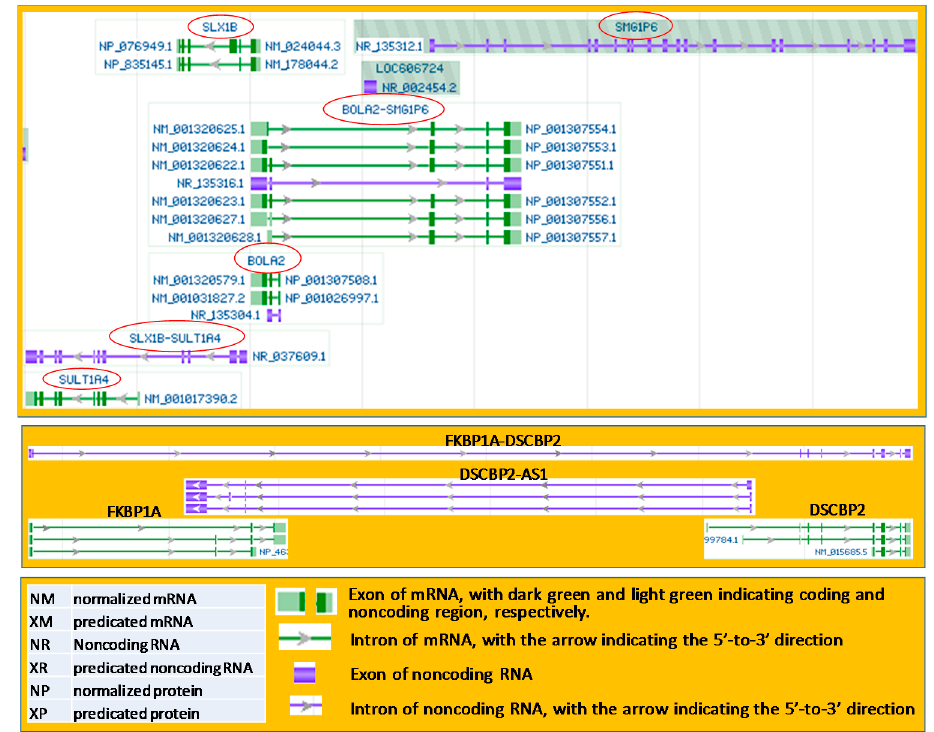
Figure 3. Illustrations copied and modified from the NCBI database showing transcripts from both strands of the DNA double helix. Top panel : the protein-coding BOLA2 gene and the noncoding SHG1P6 gene on the plus DNA strand together produce six BOLA2 - SMG1P6 messenger RNAs (mRNAs) and one noncoding BOLA2 - SMG1P6 RNA, while the protein-coding SLX1B and SULT1A4 genes on the minus strand together produce a SLX1B - SULT1A4 noncoding RNA. All genes or RNAs mentioned are highlighted with red circles. Middle panel : The protein coding FKBP1A and SDCBP2 genes on the plus strand of the human 20p13 region together produce a FKBP1A - SDCBP2 noncoding RNA, while the minus DNA strand of this region is also transcribed to three antisense (AS) RNAs that overlap, in a reverse-complementary manner, with an end of the FKBP1A and SDCBP2 mRNAs. The overlaps can easily lead to creation of an artificial FKBP1A - SDCBP2 cDNA during reverse transcription (RT) or PCR, as we described before [5,6,64,105]. Bottom panel : The NCBI database uses NM, XM, NR, XR, NP, and XP to indicate normalized mRNA, predicated mRNA, noncoding RNA, predicated noncoding RNA, normalized protein, and predicated protein, respectively, while it uses green and blue colors to indicate mRNA and noncoding RNA, respectively. The NCBI also uses boxes and lines to indicate exons and introns, respectively, with their lengths in proportion to the lengths of the exons or introns in the number of nucleotides (RNA) or base-pairs (DNA).